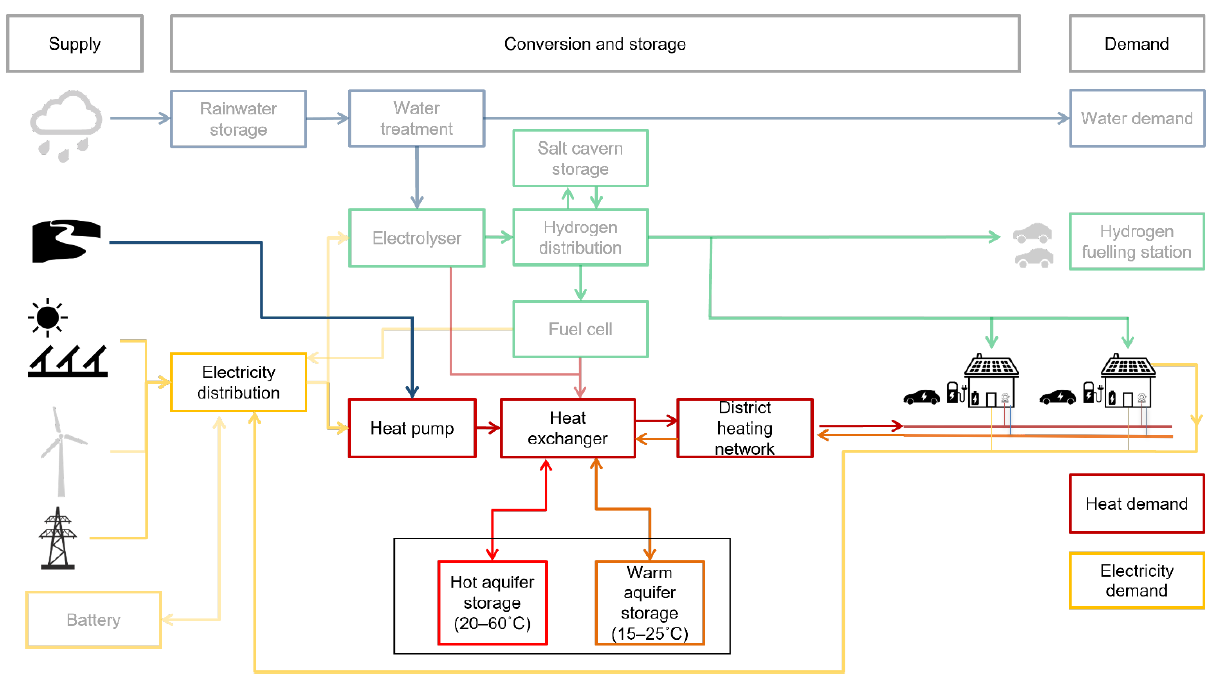
Figure 2. Overview of the components in the multi-energy system model, with a highlight on the model parts that are the focus of this paper.